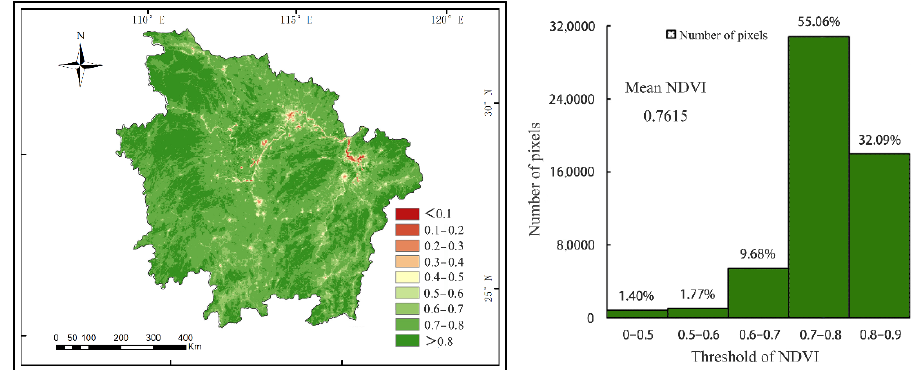
Figure 4. Spatial distribution of mean NDVI and pixel distribution in the MRYR from 1999 to 2015.